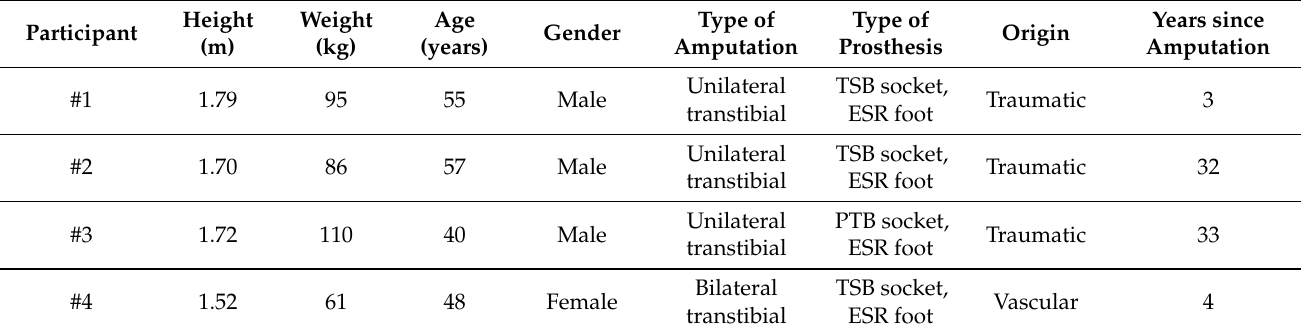
Table 4. Characteristics of lower-limb amputated participants.